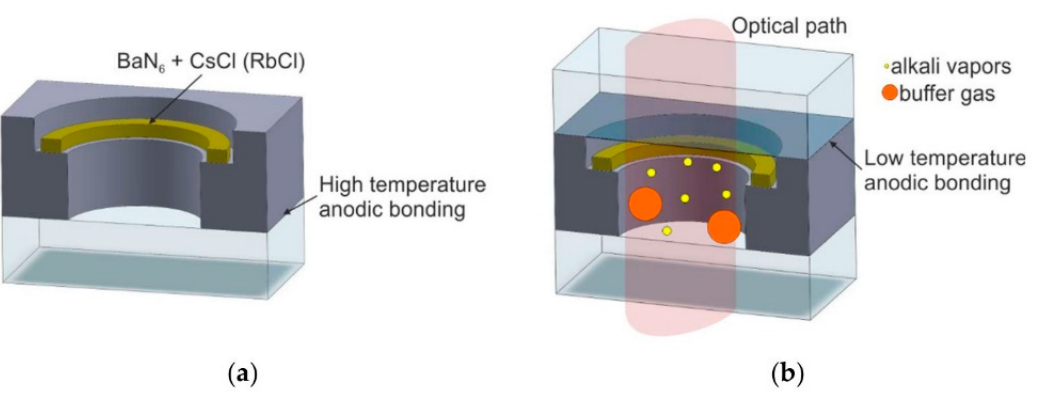
Figure 14. Vapor cell prepared by the chemical reaction to manufacture alkali monomers. ( a ) chemical reaction to form alkali metal, ( b ) optical path of alkali vapor cell. Reprinted from Ref [56].